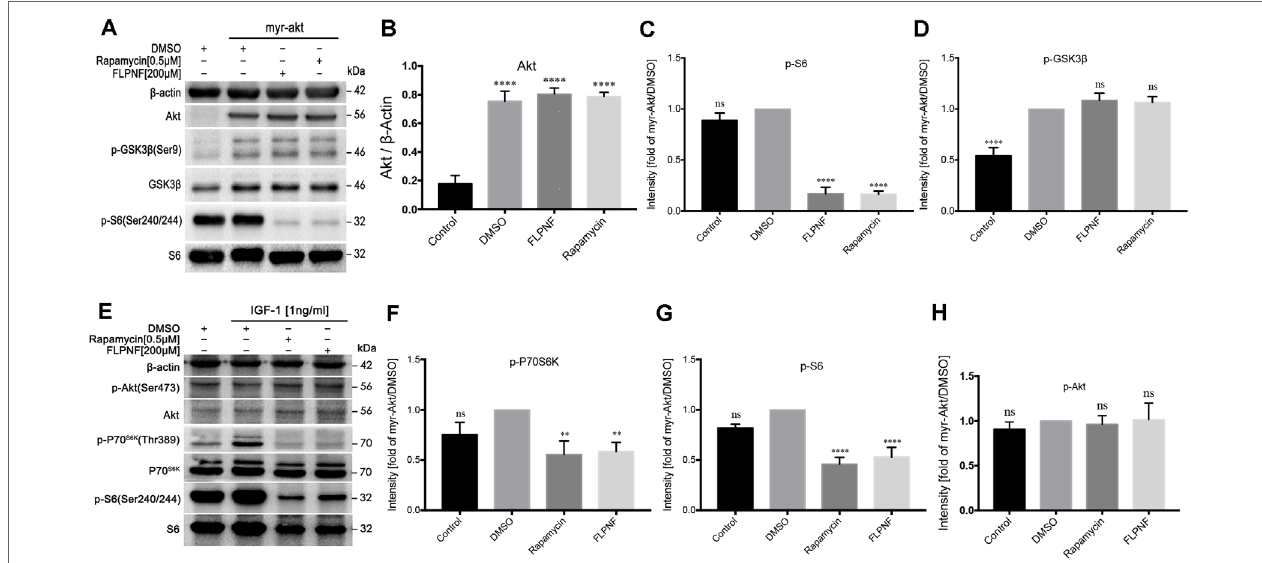
FIGURE 5 | Peptide FLPNF inhibits mTORC1 but not mTORC2 activity. (A) Protein levels of Akt, phosphorylated S6, and phosphorylated GSK3 β were assessed by Western blot in HEK-293 cells expressing either a control vector or a myr-Akt expression vector after exposure to 200μM peptide FLPNF for 24 h. (B) The graph represents the quantification of Akt protein levels (n = 4). **** p < 0.0001 vs. control group. (C) and (D) The graph represents the quantification of phosphorylated S6 and GSK3 β protein levels, respectively (n = 4). Band intensities were quantified and statistically analyzed relative to myr-Akt-expressing/DMSO-treated cells. **** p < 0.0001, and ns vs. myr-Akt-expressing/DMSO-treated group. (E) Protein levels of phosphorylated P70S6K, S6, and Akt were assessed by Western blot in hIAPP-INS-1 cells after exposure to 200 μM peptide FLPNF for 24 h. IGF-1 (1 ng/mL) was added for the final 20 min. (F – H ) The graph represents the quantification of phosphorylated P70S6K, S6, and Akt protein levels, respectively (n = 4). Band intensities were quantified and statistically analyzed relative to IGF-1/DMSO-treated